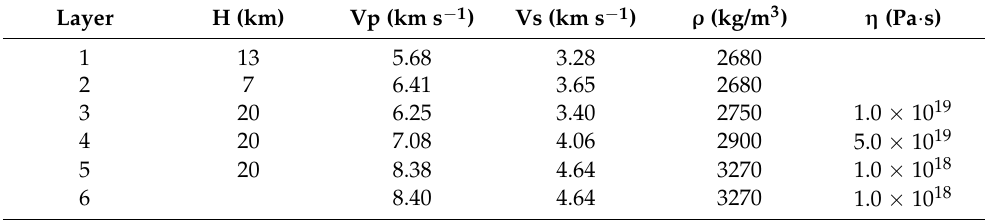
Table 1. Model parameters.